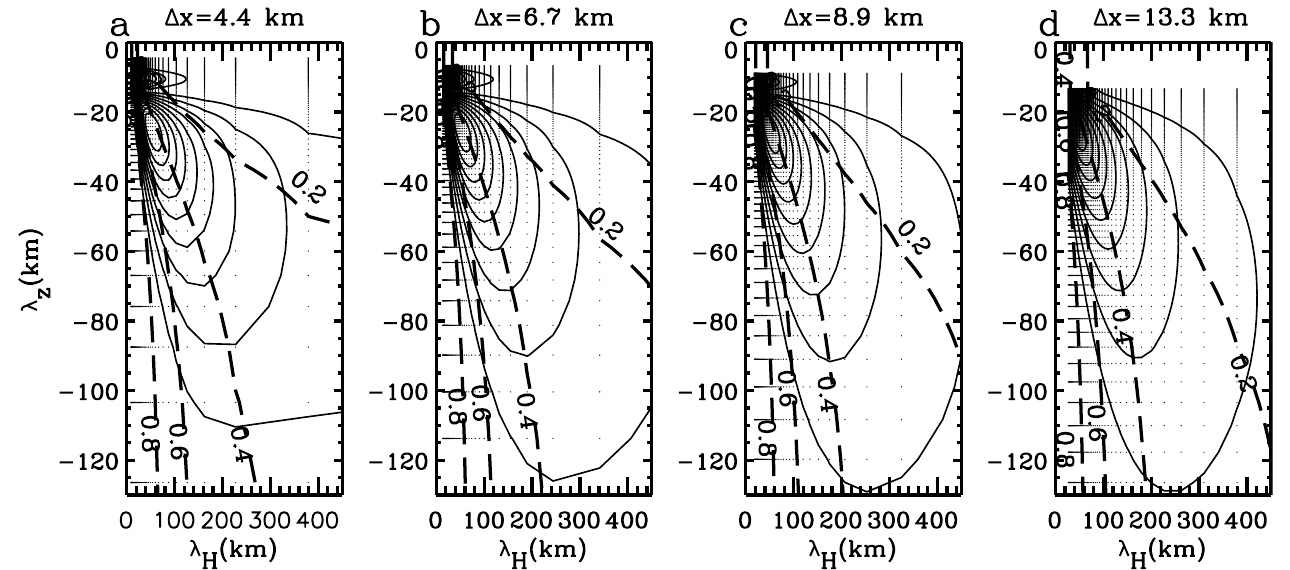
Fig. 7. Zonal velocity spectra for the same convective plume as in Fig. 4b. Dots show λ H and λ z for each GW. In (a) , (b) , (c) , and (d) , 1x = 4 . 4 , 6 . 7 , 8 . 9, and 13 . 3km, respectively. Thick long dash lines show ω Ir /N in intervals of 0 .